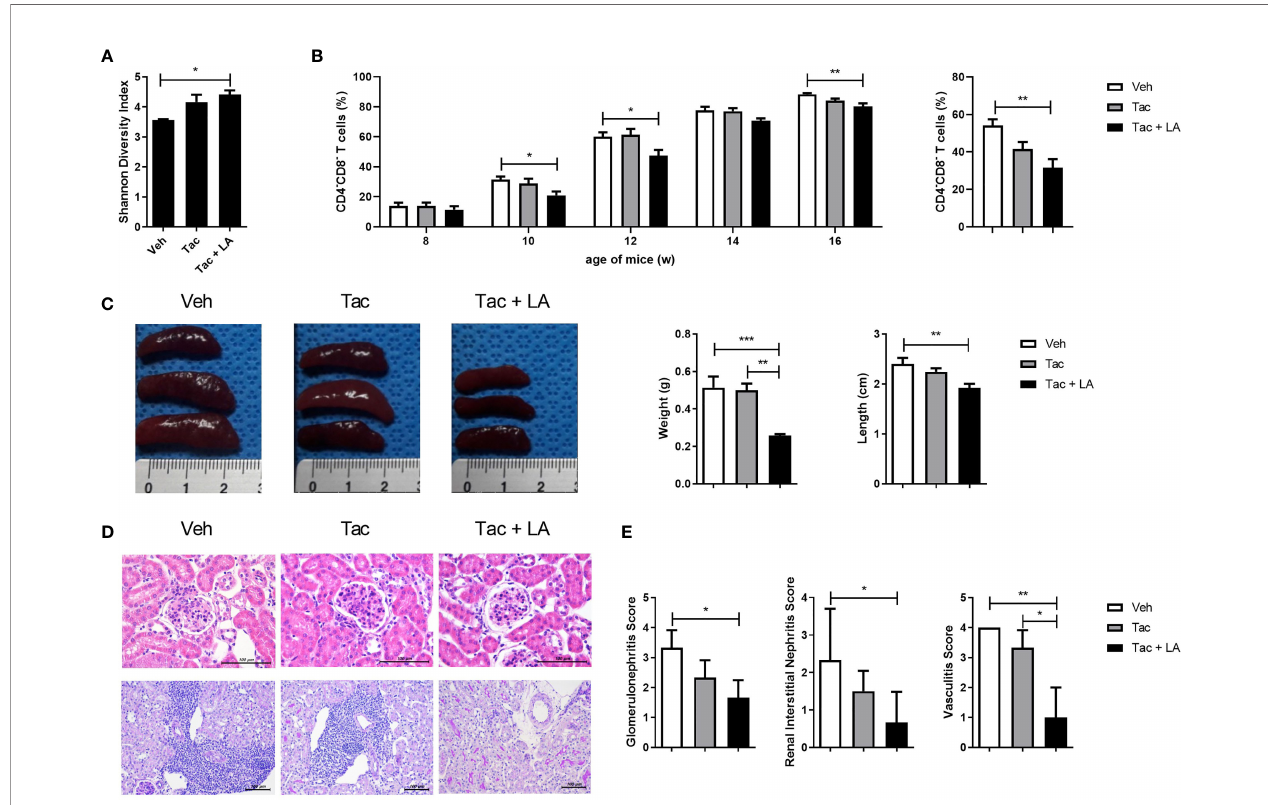
FIGURE 2 | The combination of Tac and LA improves gut dysbiosis and reduces the proportion of DNT cells and kidney in fl ammation in lupus mice. Eight-week-old MRL/ lpr mice ( n = 5 in each group) were orally administered Tac (5 mg/kg, daily for 8 weeks) alone, or Tac + LA (50 mg/kg, daily for 8 weeks). (A) Shannon diversity indices of the cecal microbiota from MRL/ lpr mice at 16 weeks old. (B) The proportion of DNT (CD4-CD8-) cells in the peripheral blood of MRL/ lpr mice during in vivo experiments (left panels). The percentage of DNT cells in the spleens of 16-week-old MRL/ lpr mice (right panels). (C) The weights and lengths of spleens from 16-week-old MRL/ lpr mice. (D) Representative photomicrographs of haematoxylin and eosin (H&E)-stained renal tissues of 16-week-old MRL/ lpr mice. Glomeruli and tubules (upper panels, original magni fi cation ×400) and vascular pathologies (lower panels, original magni fi cation ×200). (E) Semiquantitative in fl ammation scores calculated from the renal tissue sections. All experiments were performed at least three times in triplicate. Data are shown as mean ± SEM. * p < 0.05, ** p < 0.01, *** p <